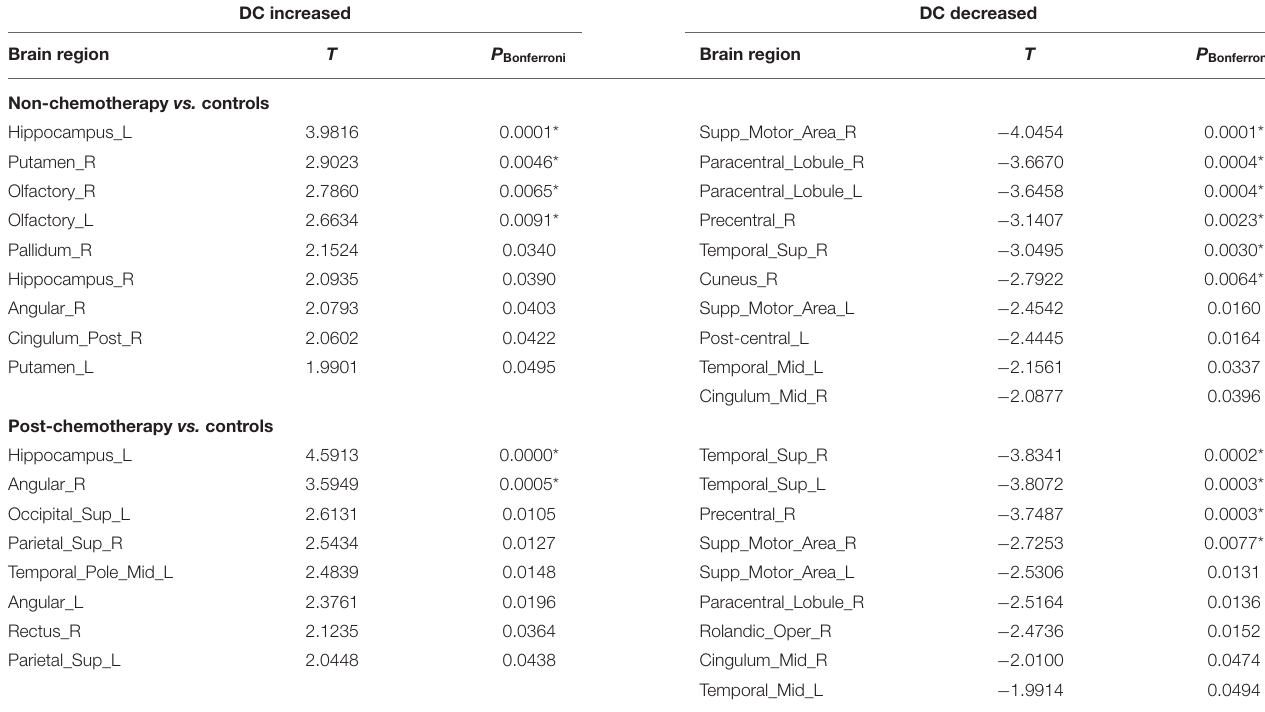
The P Bonferroni values are obtained by using the Bonferroni calibration. P Bonferroni < 0.05 is considered significant. * P Bonferroni < 0.01.